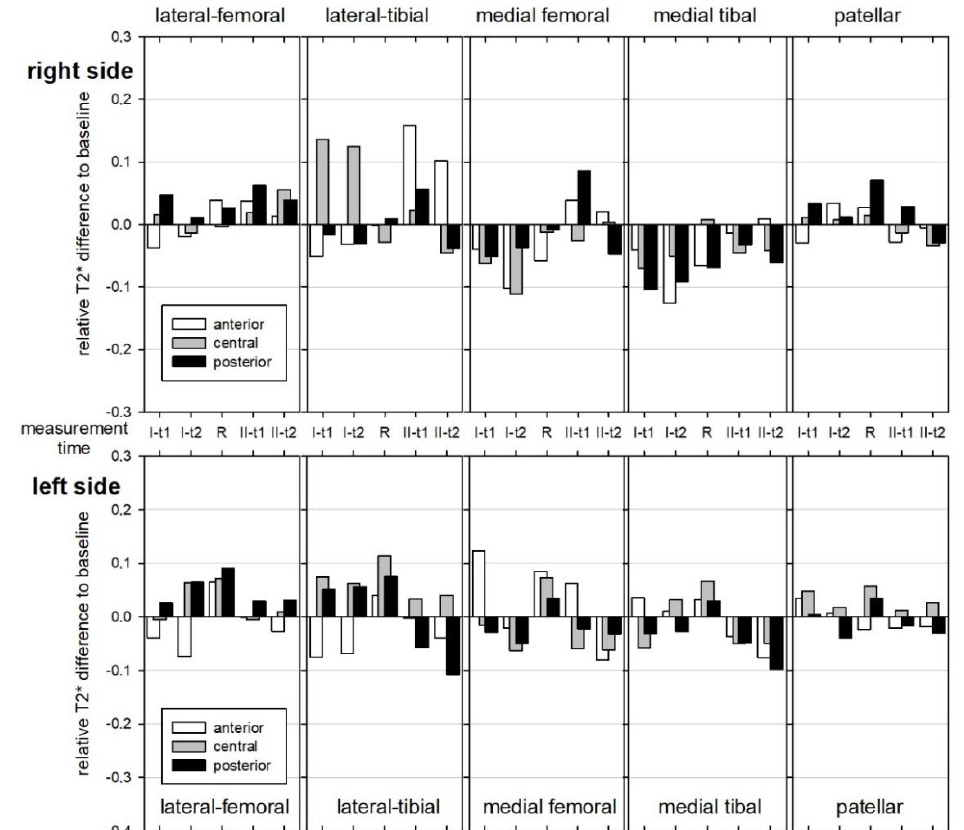
Figure 6. Relative Changes of Zone-Related Mean T2* Time in the Knee Joint Regions.